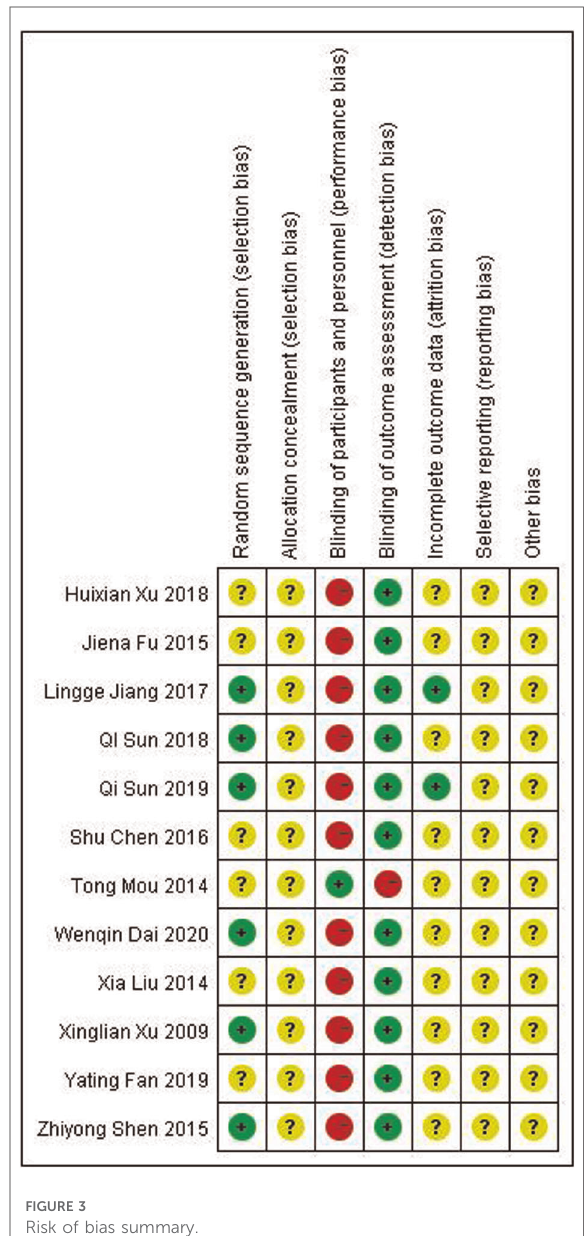
FIGURE 3 Risk of bias